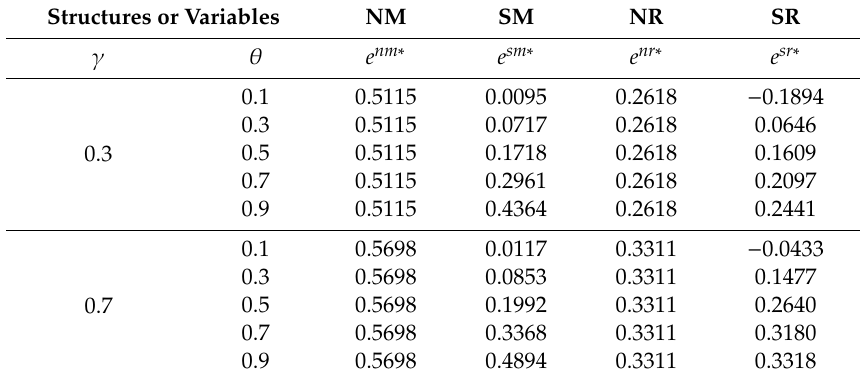
Table 4. The influence of sharing ratios on the emission-reduction level under four modes (Unit: m 3 ). Structures or